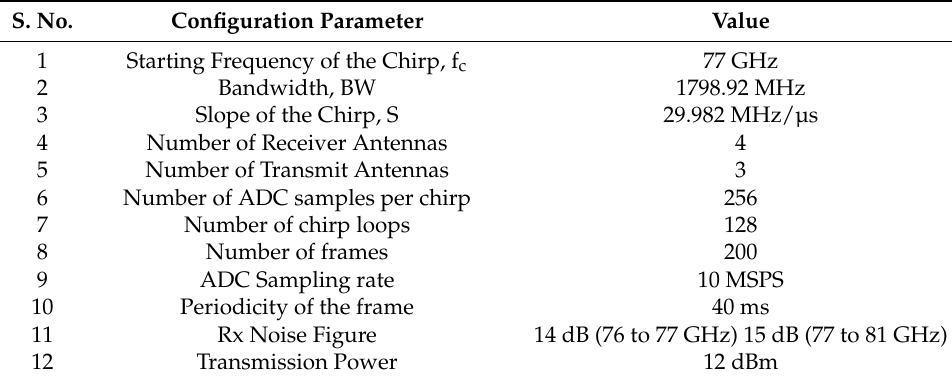
Table 1. Configuration parameters for the